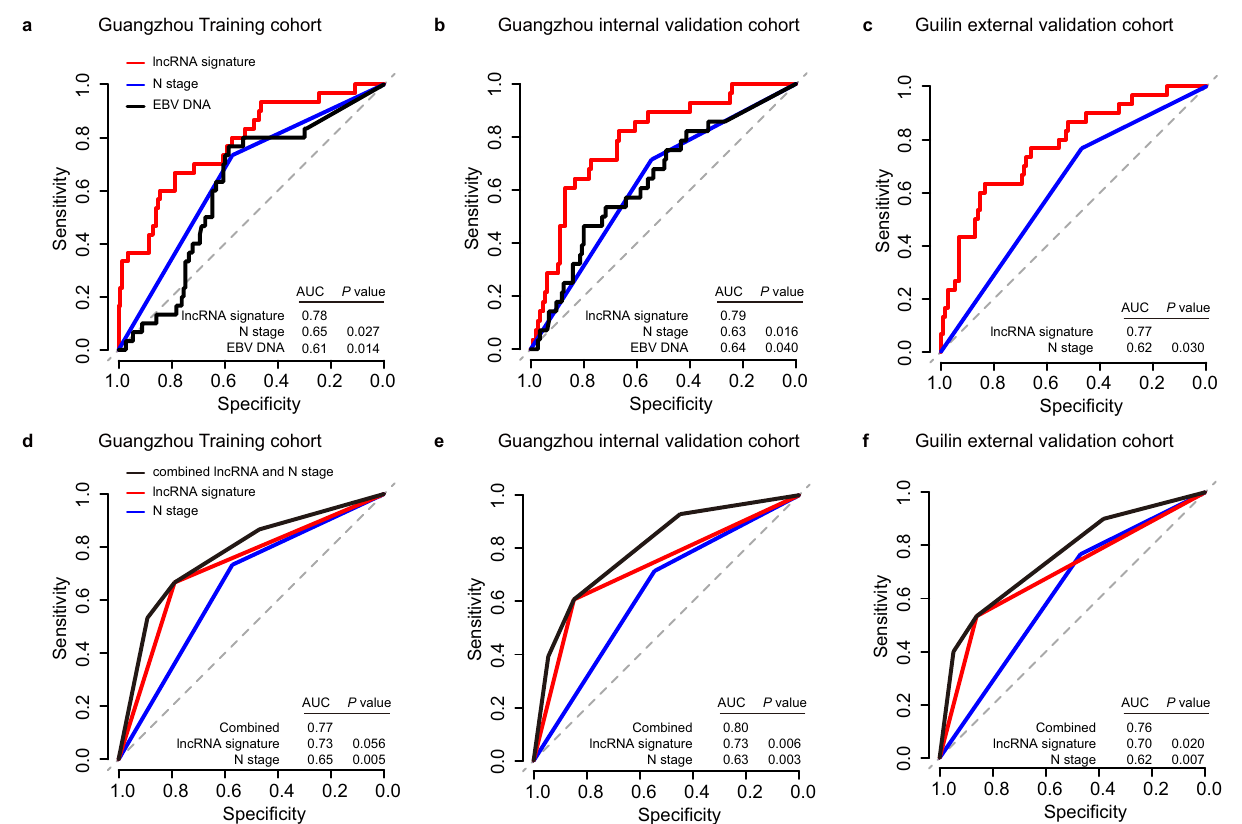
Fig. 4 Performance of the nine-lncRNA signature and clinical indicators for metastasis prediction. a – c Receiver operating characteristic (ROC) curve analysis evaluating the performance of the lncRNA signature, N stage, and EBV DNA for the prediction of distant metastasis in patients in the training ( a , n = 177), Guangzhou internal validation ( b , n = 177), and Guilin external validation ( c , n = 150) cohorts. d – f ROC curve analysis evaluating the performance of the combined model (the lncRNA signature and N stage), the lncRNA signature alone and N stage alone for the prediction of distant metastasis in patients in the training ( d , n = 177), Guangzhou internal validation ( e , n = 177), and Guilin external validation ( f , n = 150) cohorts. Two-sided DeLong ’ s test was used to estimate the P values. EBV Epstein-Barr virus, AUC area under curve. Source data are provided as a Source Data fi